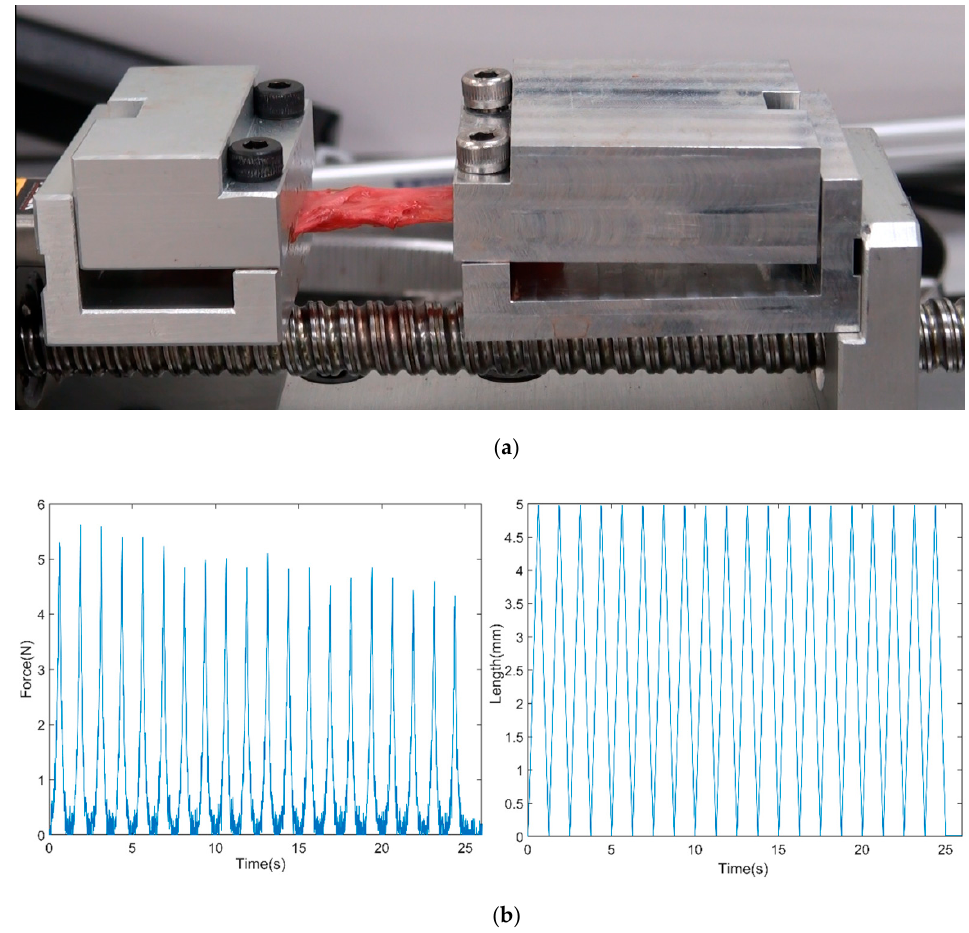
Figure 3. ( a ) An example of the test sample (Quadratus lumborum) during the test ( b ) an example of the force and length raw data from the